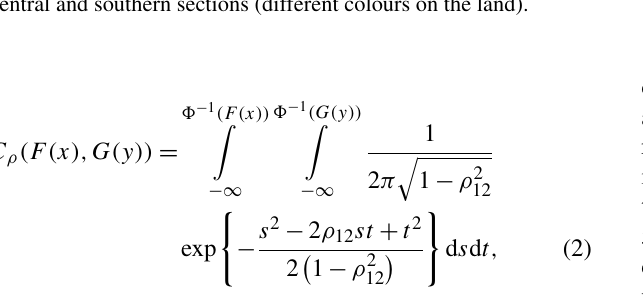
Figure 2. Study area showing the gradients in topo-bathymetry that exert a strong control over the resulting met-ocean conditions. The four transects (red lines) used to estimate the limit of the coastal fringe are depicted, located in (from south to north) (a) Ebro Delta, (b) Tarragona, (c) Badalona and (d) Begur. The map also shows the Puertos del Estado (PdE) buoys and the division of the Catalan coast into the northern, central and southern sections (different colours on the